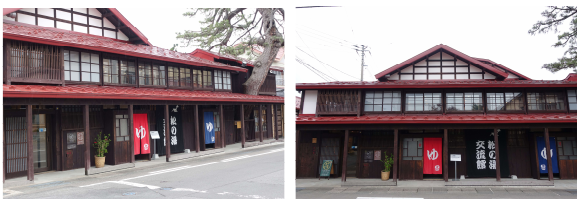
Figure 4. Pictures of the Former Matsuno-Yu building from on- site survey in 2018 after the restoration.